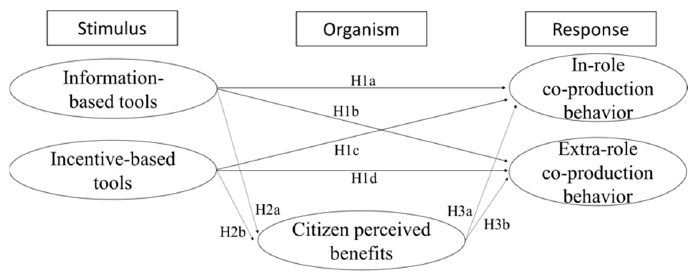
Figure 1. The proposed research model.